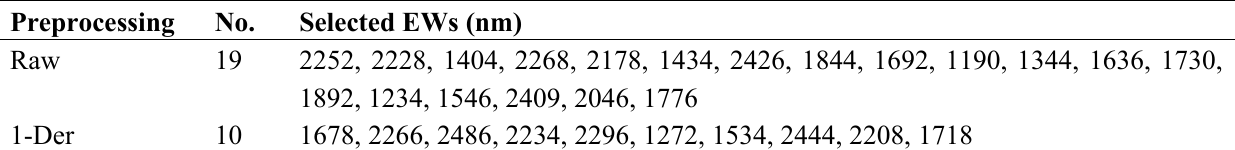
Table 3. Selected effective wavelengths (EWs) by SPA.